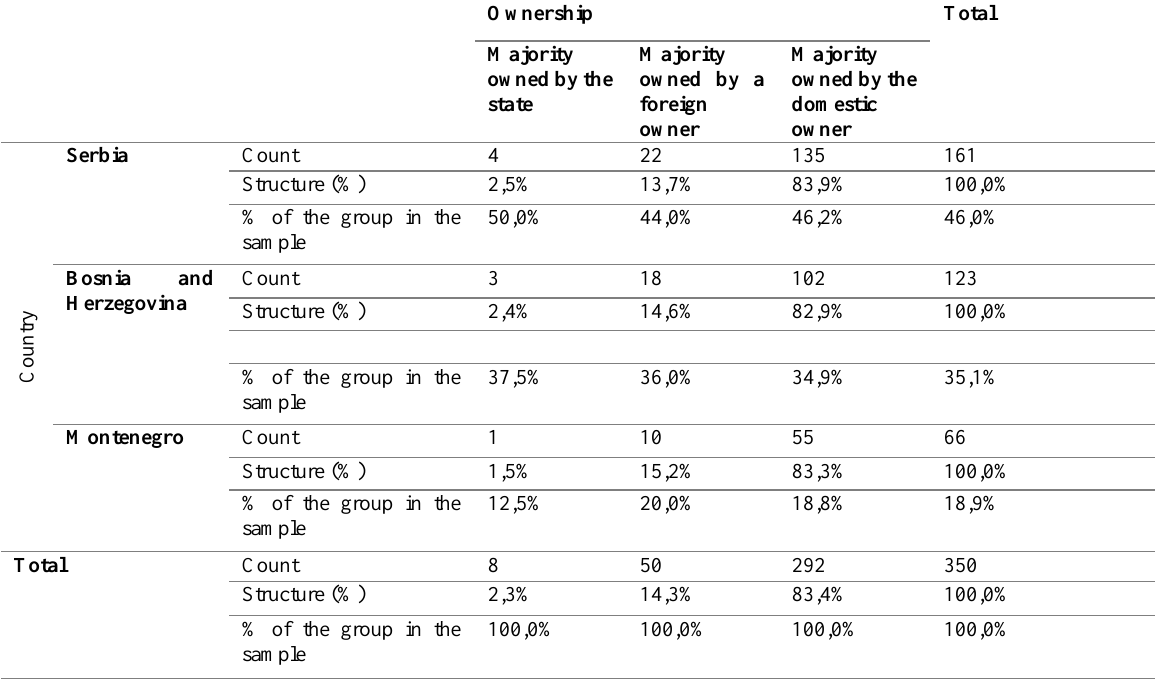
Table 4: Ownership of